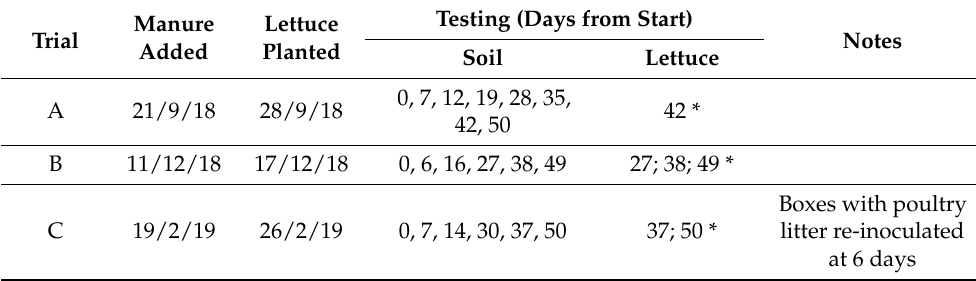
Table 1. Trial start, lettuce planting and sampling